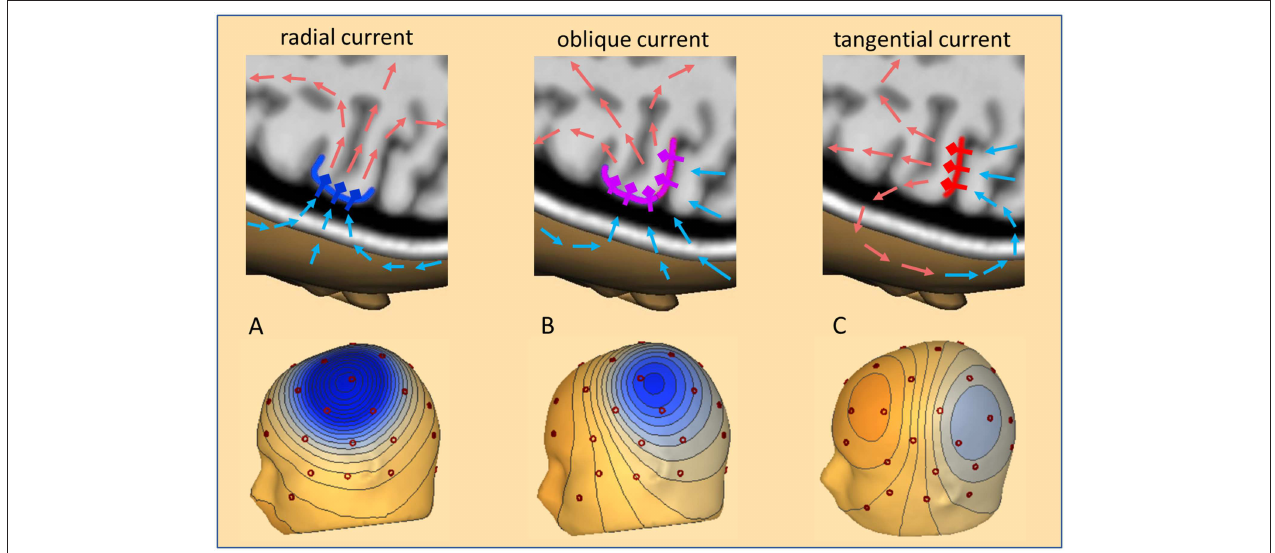
FIGURE 1 | Cortical currents, volume currents, and scalp topography. Three cases of IED current inflow into a focal cortical patch are illustrated: (A) radial (dark blue), (B) oblique (pink), (C) tangential (red). Pyramidal cells and their apical dendrites are symbolized by diamonds and thick outward bars. A subset of return current loops is depicted by arrows in light red to illustrate where they create positive and light blue where they create negative voltages. Depending on the net orientation of the cortical patch, the zone of maximal inflow from scalp into depth shifts from above the patch (A) , to more posterior (B) and fully posterior (C) . These currents create the